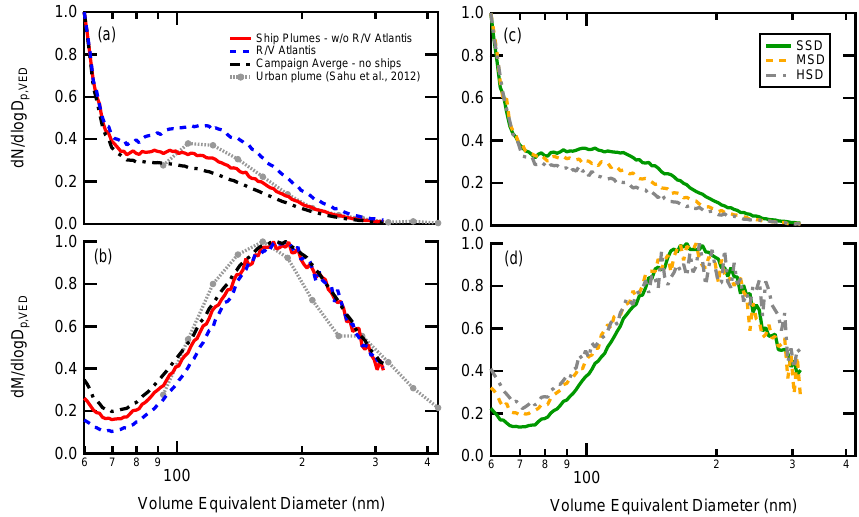
Fig. 3. Average normalized, number-weighted (a) and mass-weighted (b) size distributions for the rBC component of particles, as measured using the SP2 for all ships excluding the Atlantis (red line), the Atlantis only (dashed blue line) and the campaign average, excluding ship plumes (black dot-dashed line). A size-dependent detection efficiency has been applied (see text for details). For comparison, scaled rBC size distributions from Sahu et al. (2012) for urban plumes in CA are shown (dashed grey lines). (c) and (d) show the corresponding rBC size distributions averaged by ship engine category (and where the MSD category average excludes the